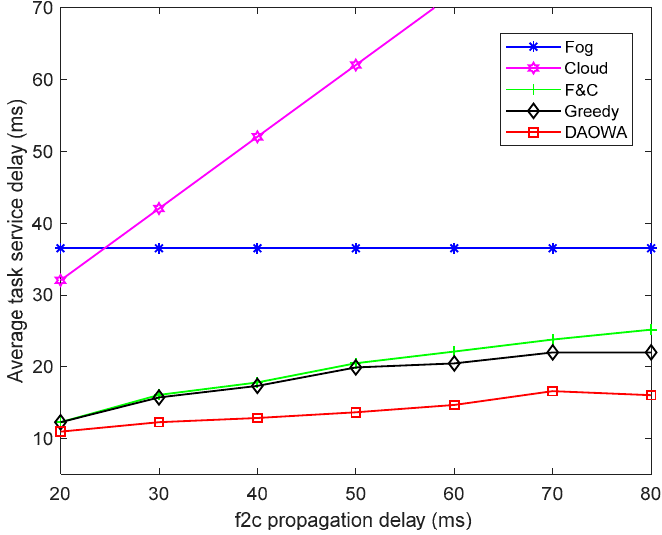
Figure 8. Average task service delay vs. f2c propagation Figure 8 . Average task service delay vs. f2c propagation delay.